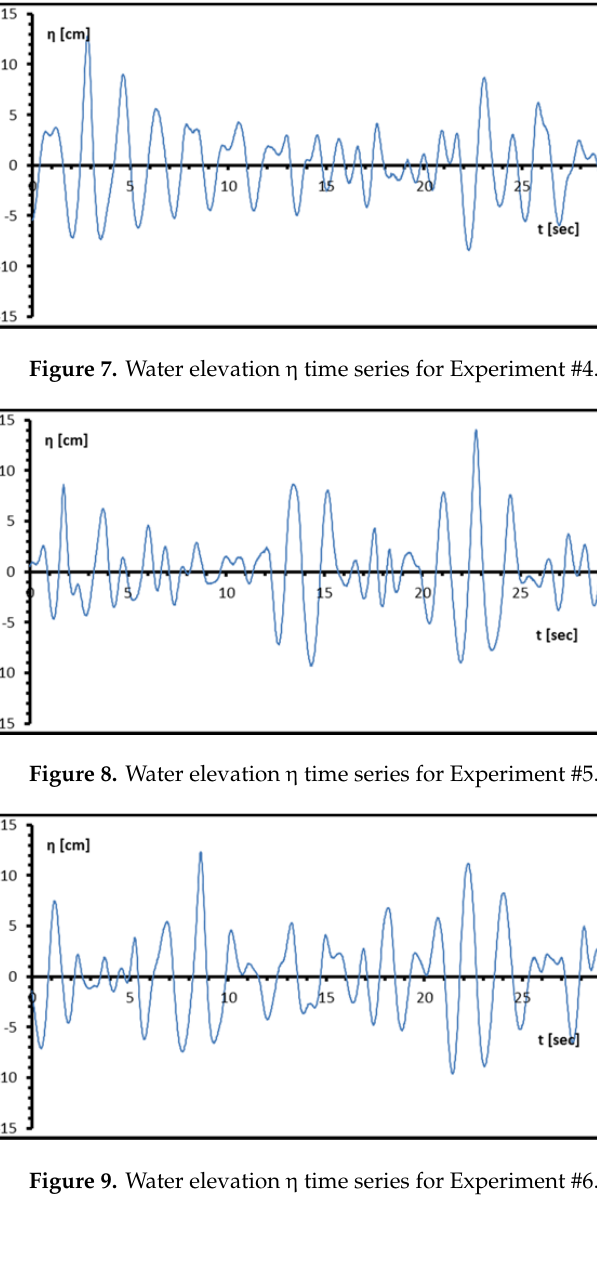
Figure 10. Water elevation η time series for Experiment #7. Figure 11. Water elevation η time series for Experiment #8. Figure 12. Power Density Spectrum, Bretschneider vs. Measured.